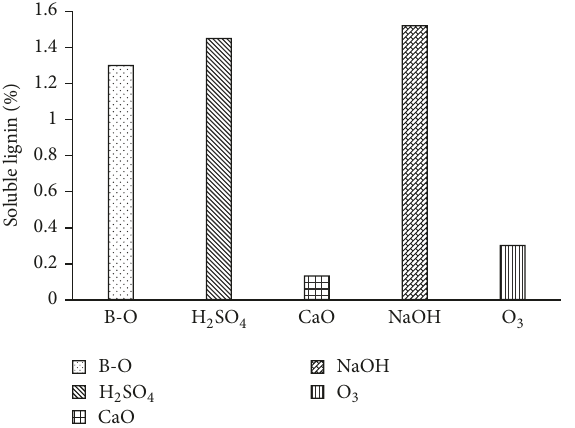
Figure 5: Concentration of soluble lignin based on the different pretreatments made to cellulose-based